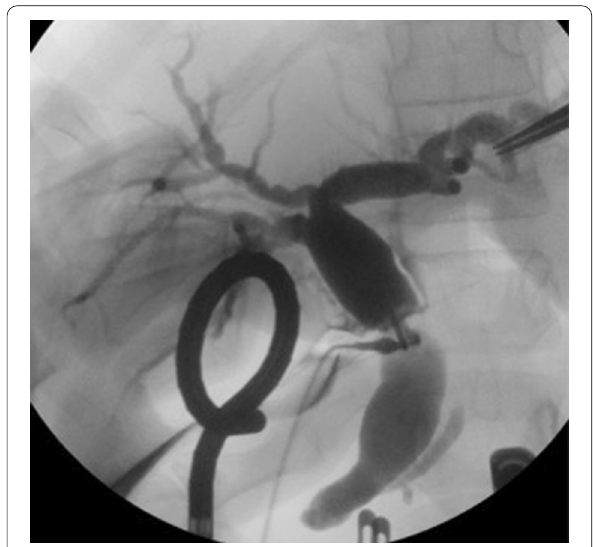
Fig. 2 Intraoperative cholangiography. Intraoperative cholangiography performed by direct puncture of the dilated common bile duct does not show the gallbladder or the cystic lesion in the hepatic hilum. The anterior and posterior segment branches separately join the common hepatic duct